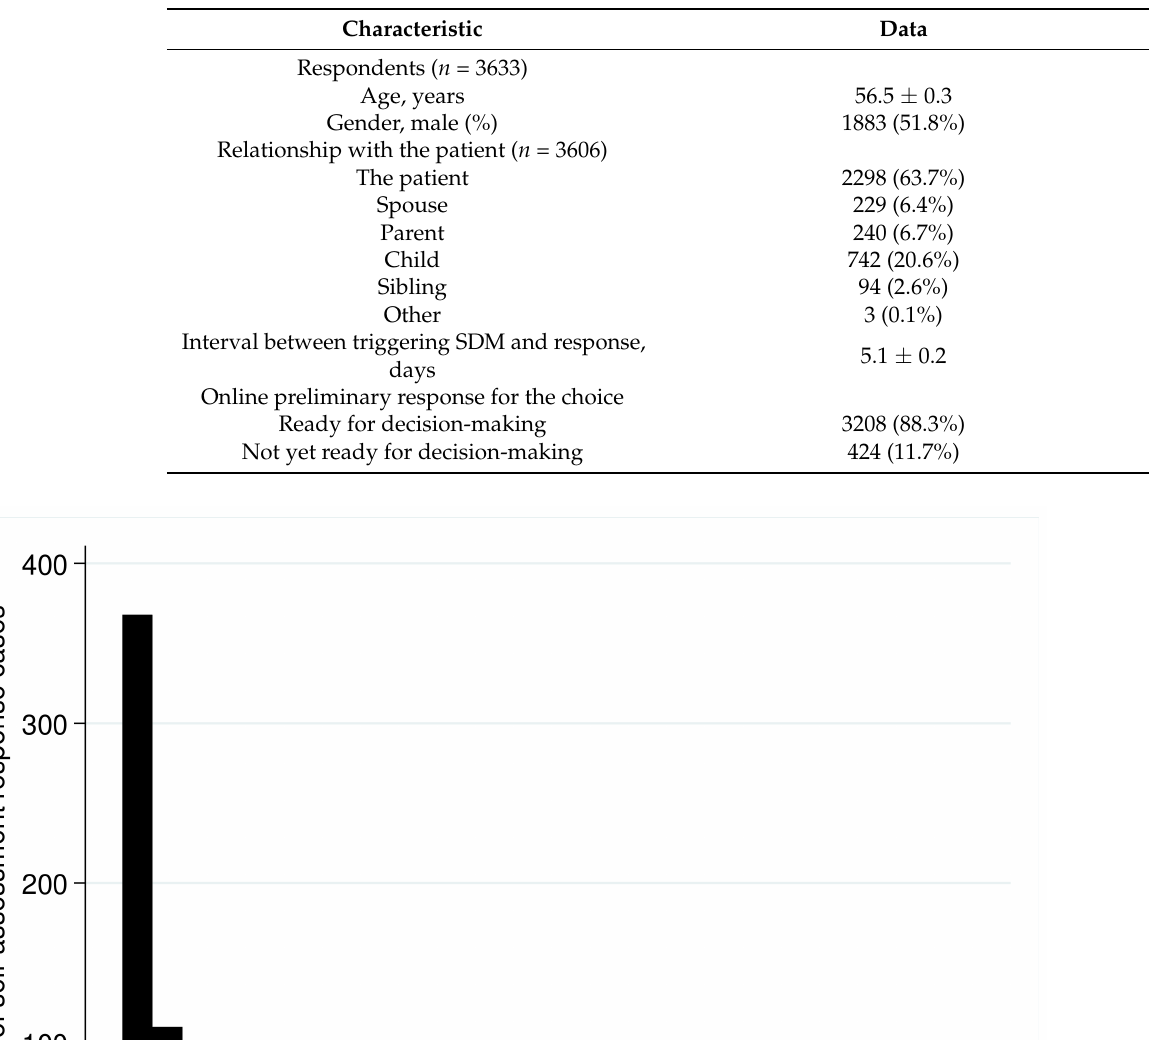
Table 3. Characteristics of the respondents and SDM team ( n = 3633).